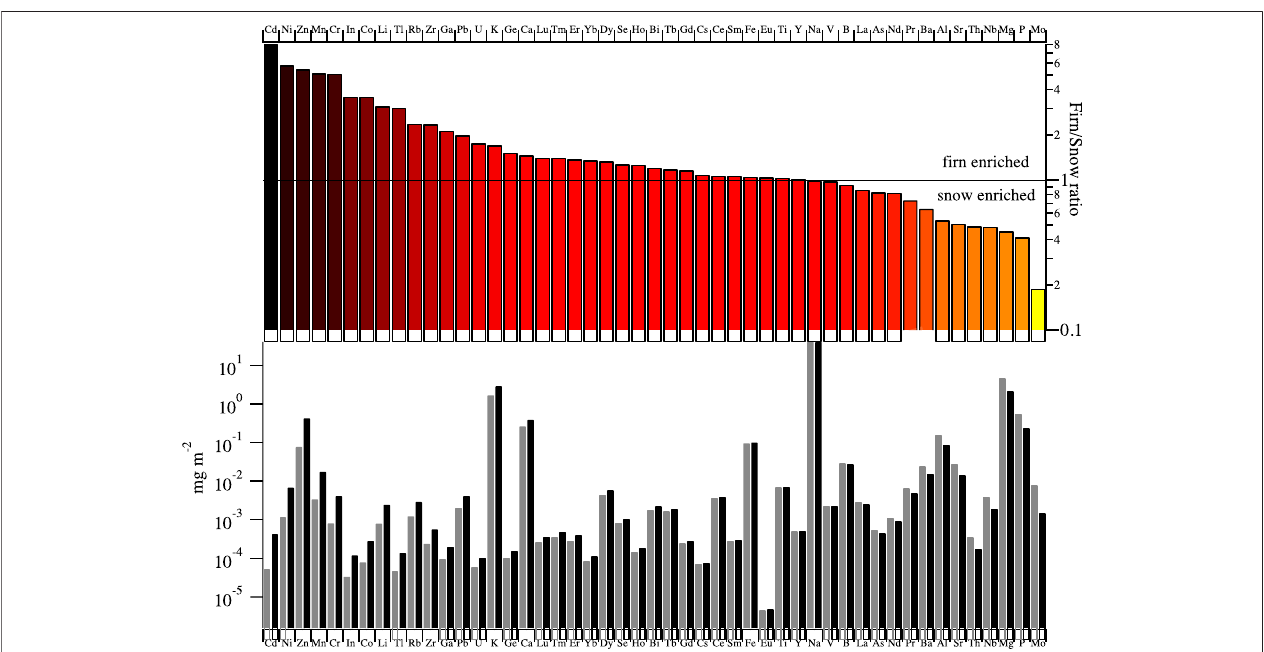
FIGURE3| Firnandsnow fl uxandtheirratiofortheanalyzed elements.Theupperpanelshowsthe fi rn\snow ratioforeachelement. Theenrichmentofelementsin fi rnisrepresentedonacolorscalefromlight\yellow (low) tothedarkred (high) .Thelowerpanelshowstheaverage fl uxintheannualsnowpack(greybars)andinthe fi rn samples (black